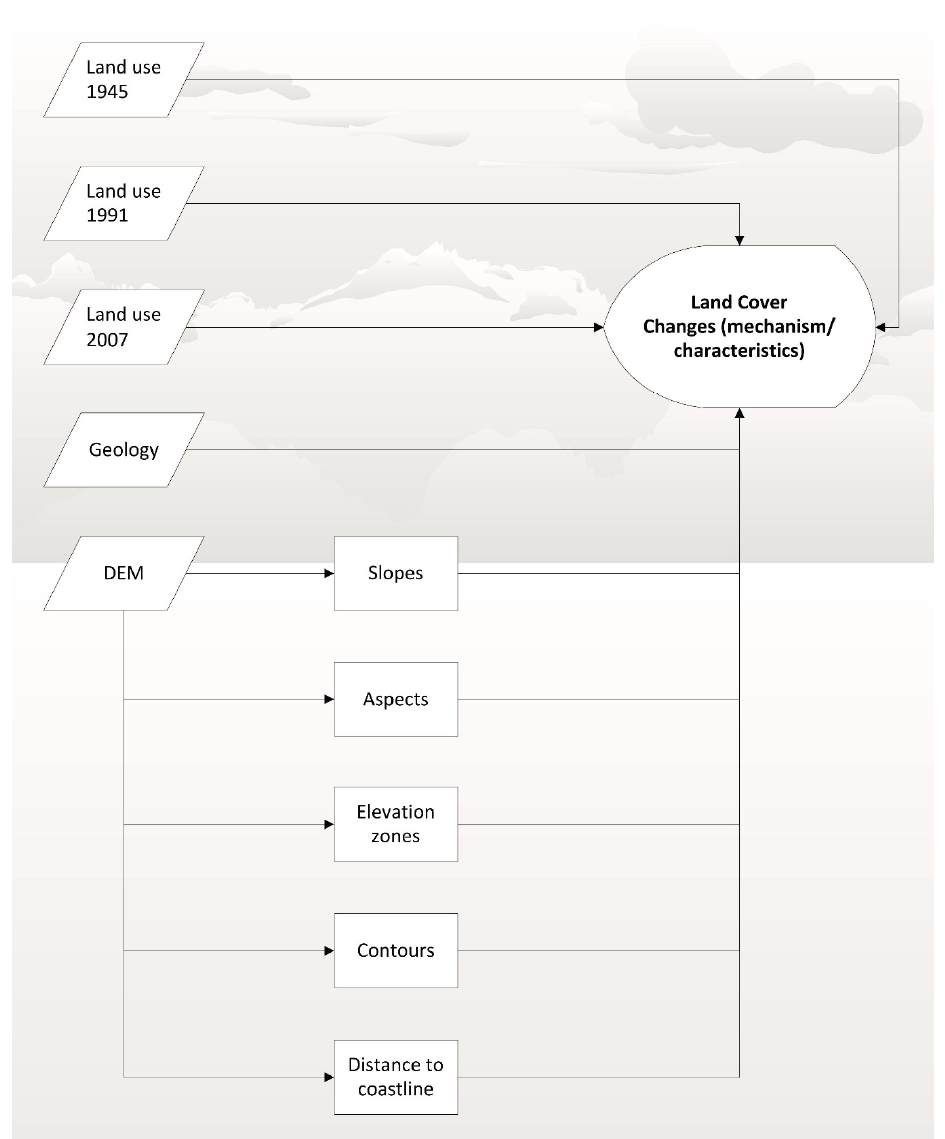
Figure 2. Flow chart of the